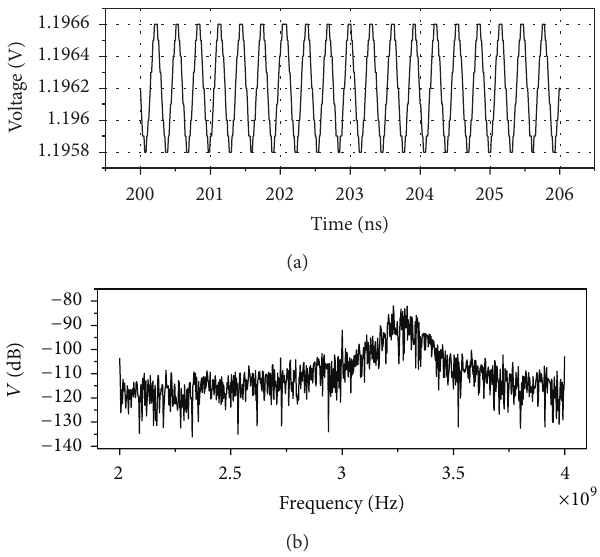
Figure 5: (a) The output voltage signal in the time domain, (b) the generation frequency in the frequency domain at 62 ∘ of the in-plane